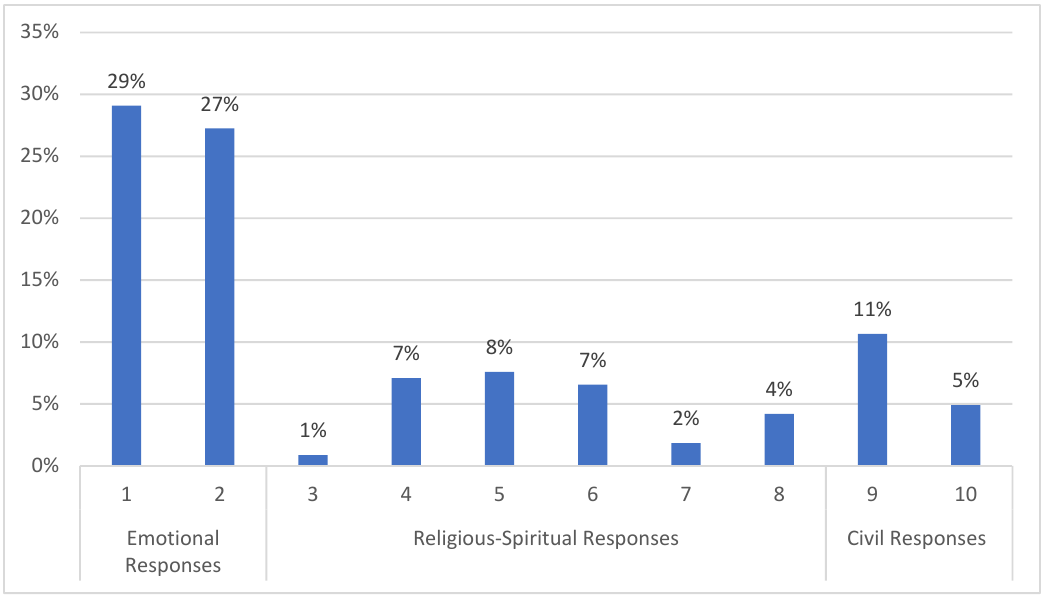
Figure 2. Distribution of Responses to the Meron Crowd Crush by Clusters and Categories (N = 1146). The number of responses in the categories referring to the past (1, 3, 5, 7 and 9) is close to the number of responses in the categories referring to the future (2, 4, 6, 8 and 10) (49% compared to 51% of all responses). In the cluster of Emotional Responses, the Past category (Category 1; 29%) is larger than the Future category (Category 2; 27%). In